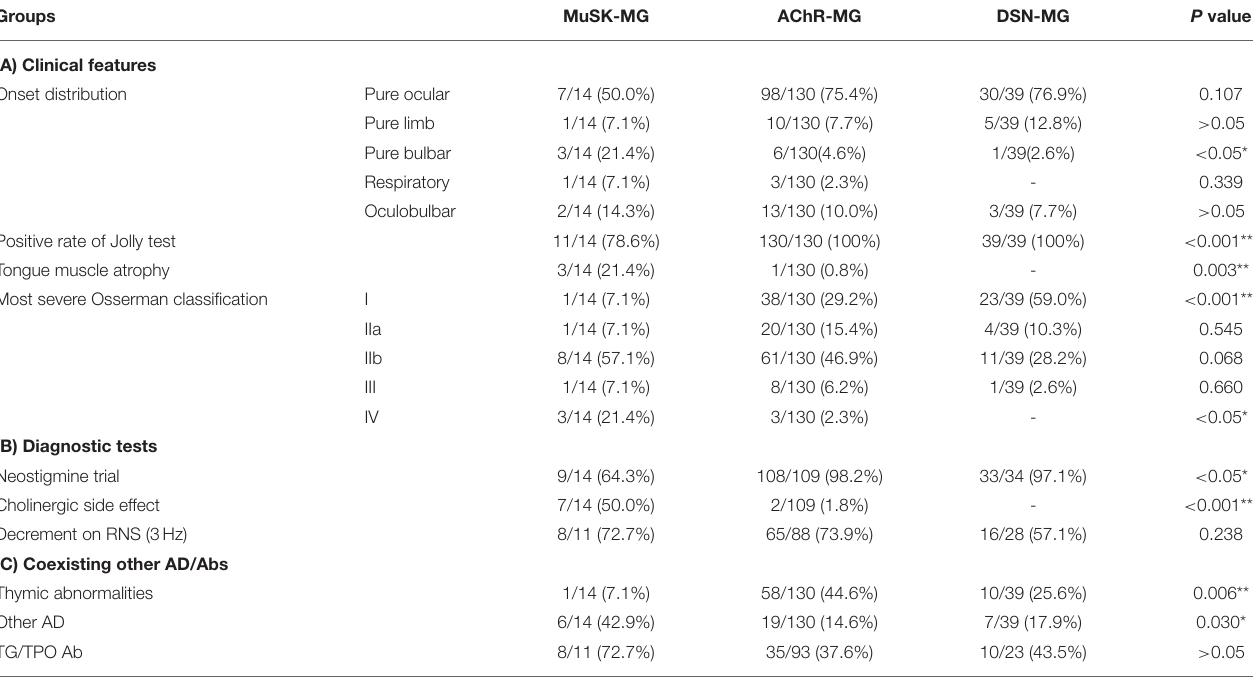
TABLE 3 | Clinical, diagnostic tests, complications, and laboratory information of three groups of patients.